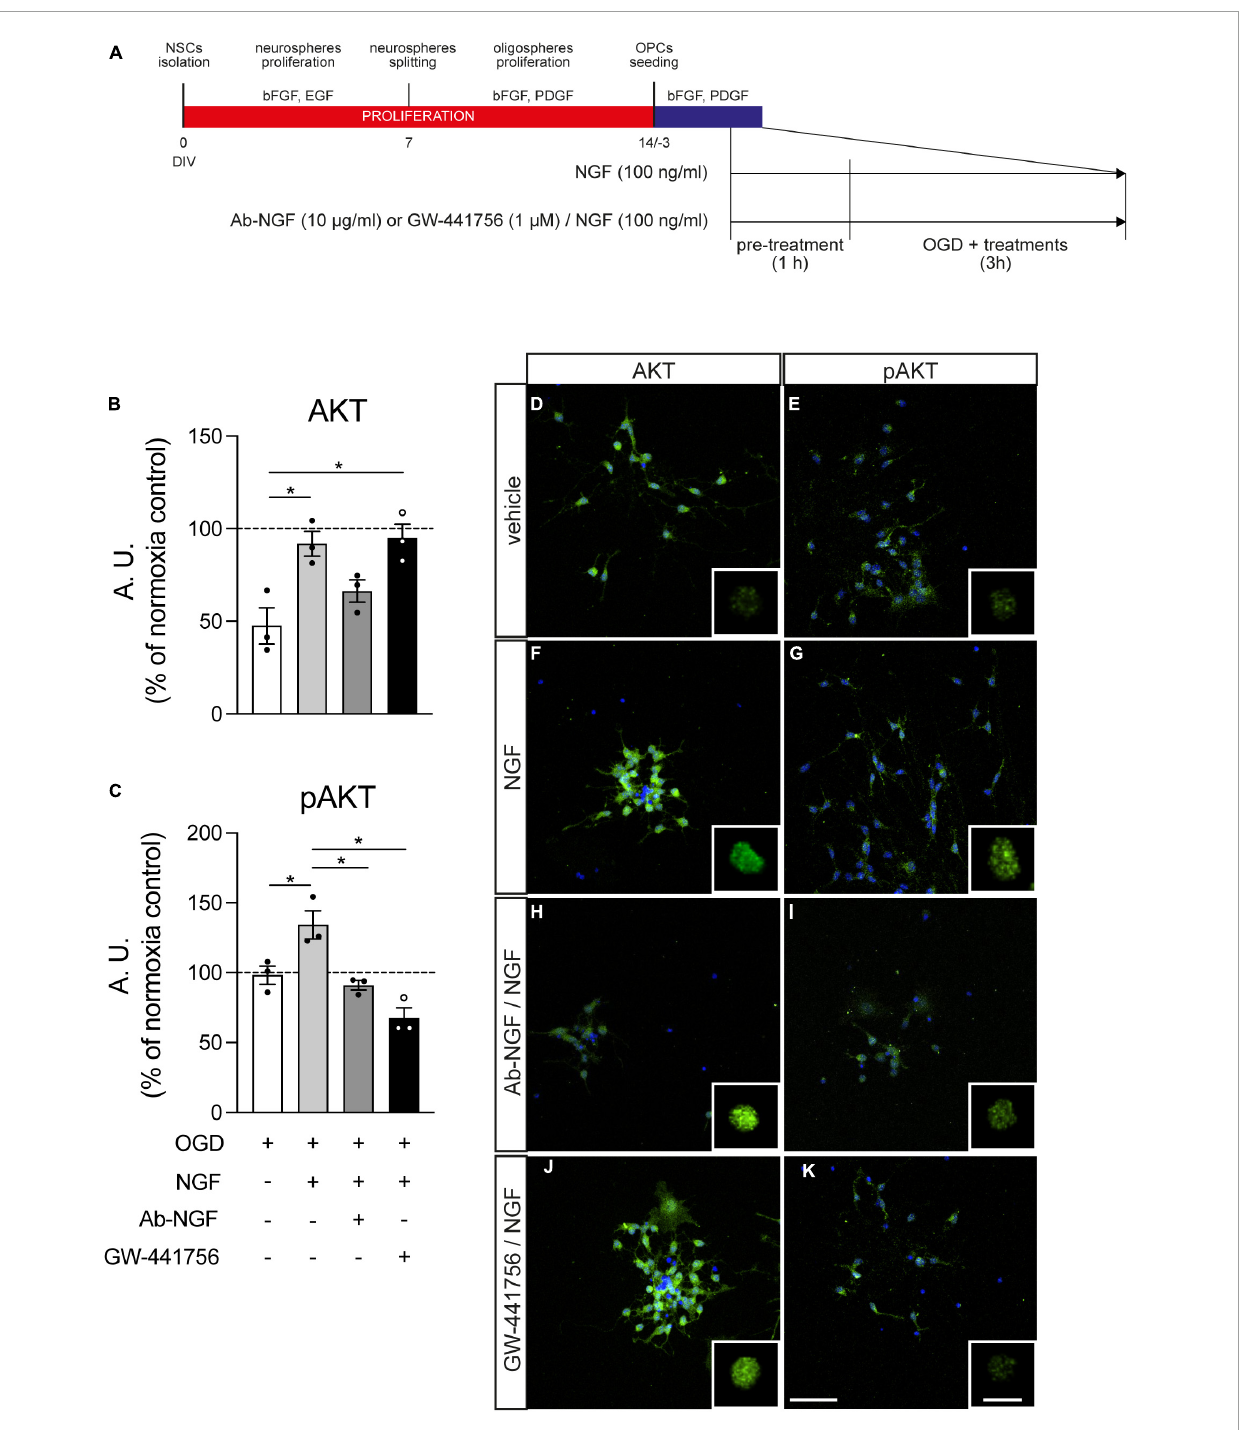
FIGURE6 Effect of NGF treatment on Akt and pAkt presence in the nucleus. (A) NSC-derived mixed OPC/astrocyte cultures were pre-treated with vehicle or NGF (100 ng/ml) alone or in combination with GW-441756 (1 µ M). Cultures were exposed to 3 h OGD and then fixed and stained for AKT or pAKT in combination with Hoechst 33258 nuclear staining. (B,C) Graphs show the quantification of AKT (B) or pAKT (C) fluorescence intensity inside the nucleus of cultures exposed to OGD and treated with vehicle (white bar), NGF (gray bar) or NGF with Ab-NGF (dark gray bar) or GW-441756 (black bar), normalized on the normoxia-vehicle treated group (horizontal dotted line); n = 3 for all the presented groups. (D–K) Representative pictures of OGD exposed cultures stained for AKT (D,F,H,J) or pAKT (E,G,I,K) and treated with vehicle (D,E) , NGF (F,G) or NGF and Ab-NGF (H,I) or GW-441756 (J,K) . Scale bar: 20 µ m. For each panel the detail of the masked AKT/pAKT staining for the nuclear volume obtained by IMARIS software is included. Scale bar: 10 µ m. Bars represent mean ± SEM and single dots in the graphs show a single independent replicate generated by the average value of five different pictures. Statistical analysis: Kruskal-Wallis test followed by Dunn’s post-test. Asterisks represent the difference between indicated groups (* p < 0.05). bFGF, basic fibroblast growth factor; DIV, day in vitro ; EGF, epidermal growth factor; NGF, nerve growth factor; NSC, neural stem cell; OGD, oxygen-glucose deprivation; T3,